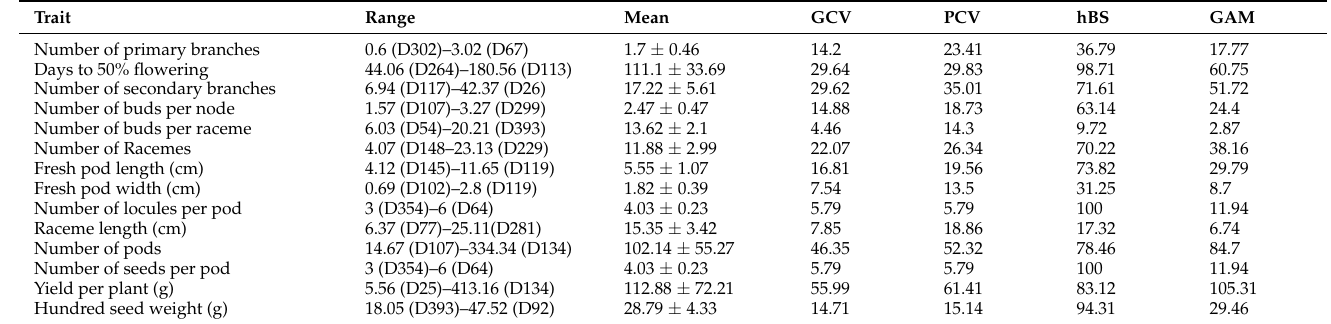
Table 1. Descriptive analysis, genetic variability and heritability values of quantitative characters of lablab accessions across two cropping seasons in Tanzania.